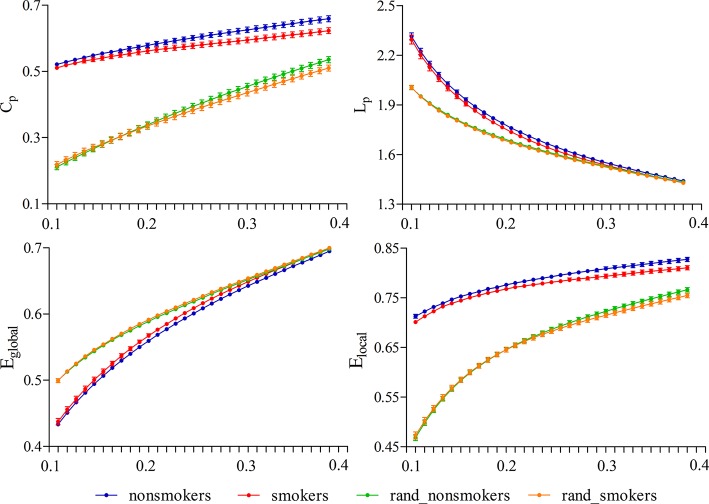
Small-world properties in the entire threshold range of 0.10 < cost < 0.40. All subjects exhibited a higher Cp and Elocal yet have approximately the same Lp and Eglobal compared to 100 random networks.